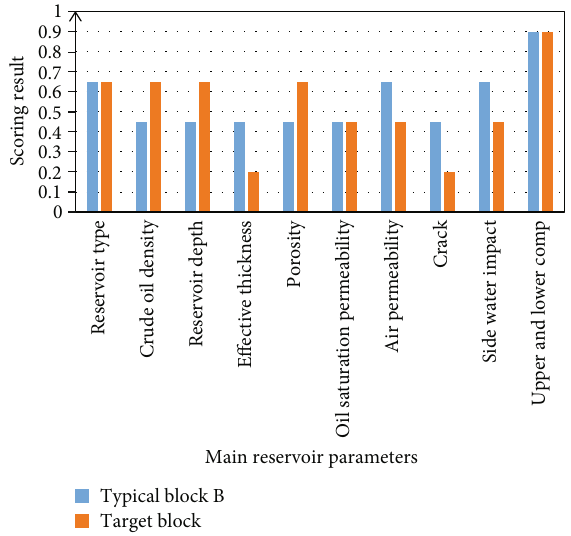
Figure 4: Scoring results of main reservoir parameters of target block and typical block B under polymer fl ooding mode.